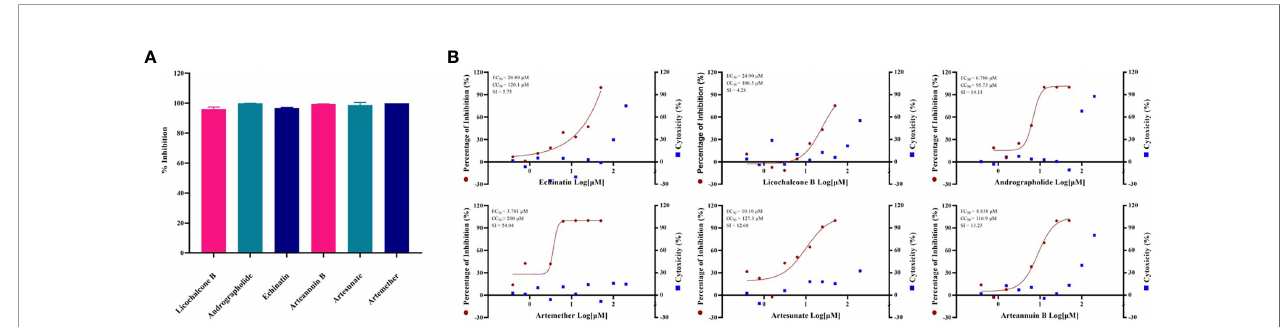
FIGURE 2 | (A) Evaluation of anti-GX_P2V effect of monomer compounds extracted from traditional Chinese medicine. Vero E6 cells were infected with GX_P2V at an MOI of 0.01. Treating with 389 different kinds of monomer compounds in the “ three formulas and three medicines ” , the fi nal concentration of each drug was 50 m M, and after 48 h, total RNA was extracted, and qRT-PCR was performed. The Y axis of the graph represents the average inhibition rate of the virus. The X-axis of the graph represents six drugs that have excellent anti-coronavirus activity. The experiments were done in triplicates. (B) EC 50 and CC 50 of six monomer compounds in “ Three Medicines and Three Prescriptions ” . Virus infection and drug treatment were performed as mentioned above. Among the drugs obtained in the preliminary screening, 6 drugs have excellent antiviral activity and low cytotoxicity, and have the potential to become speci fi c drugs for the treatment of COVID-19. The experiments were done in